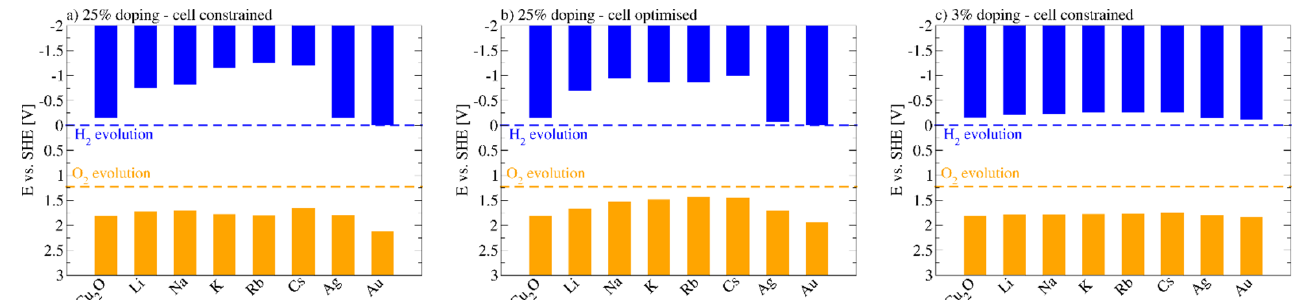
Figure 6. The band gaps of pure and alkali metal doped Cu 2 O: ( a ) 25% doping at unrelaxed Cu 2 O unit cell; ( b ) 25% doping in relaxed unit cell; ( c ) 3% doping in unrelaxed unit cell. Band alignments are stated as electrochemical potentials (E) versus the standard hydrogen electrode (SHE). Reprinted from [35] with the permission of Elsevier.